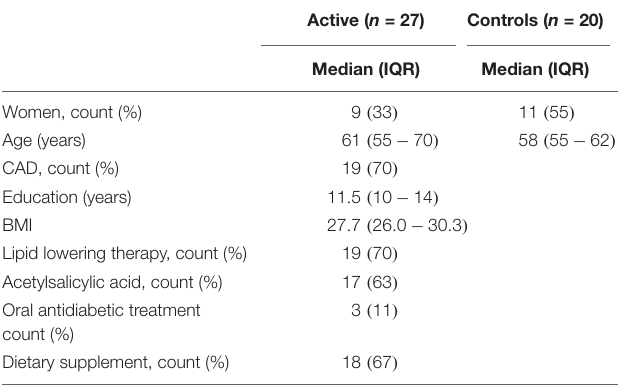
TABLE 1 | Baseline